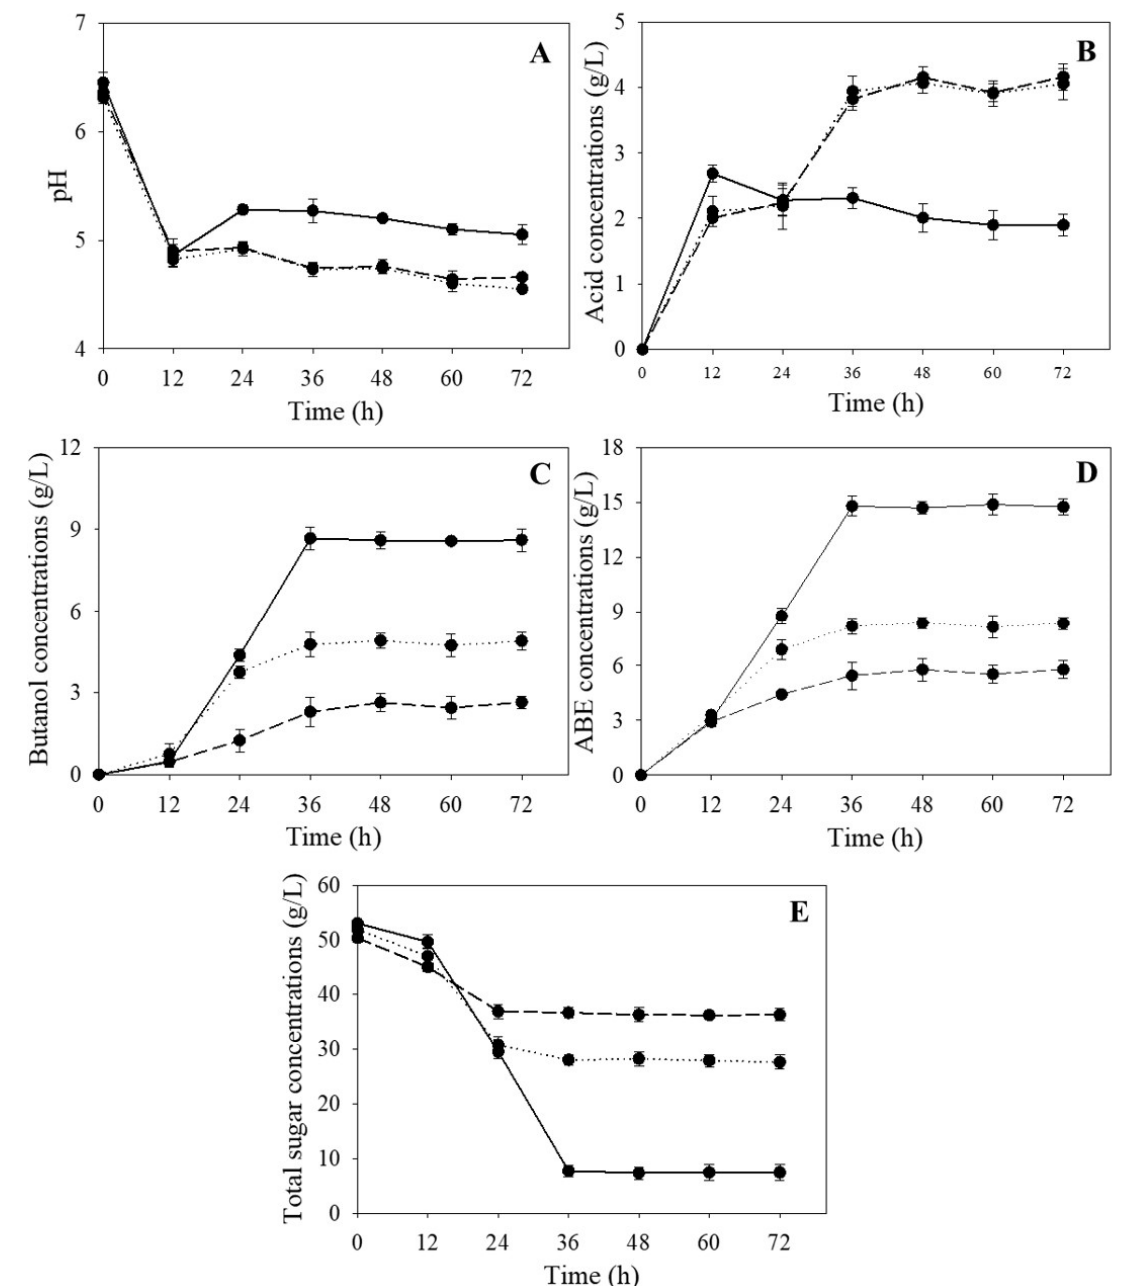
Figure 5. Profiles of ABE fermentation from sugarcane molasses by C. beijerinckii TISTR 1461 under various gas circulation rates: 0.2 (solid lines), 0.5 (dashed lines) and 1.0 (dotted lines) L/min; ( A ): pH; ( B ): acid; ( C ): butanol; ( D ): ABE and ( E ): total sugars.